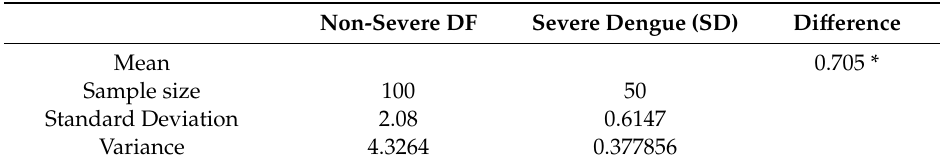
Table 1. Power calculations for the serum endotoxin